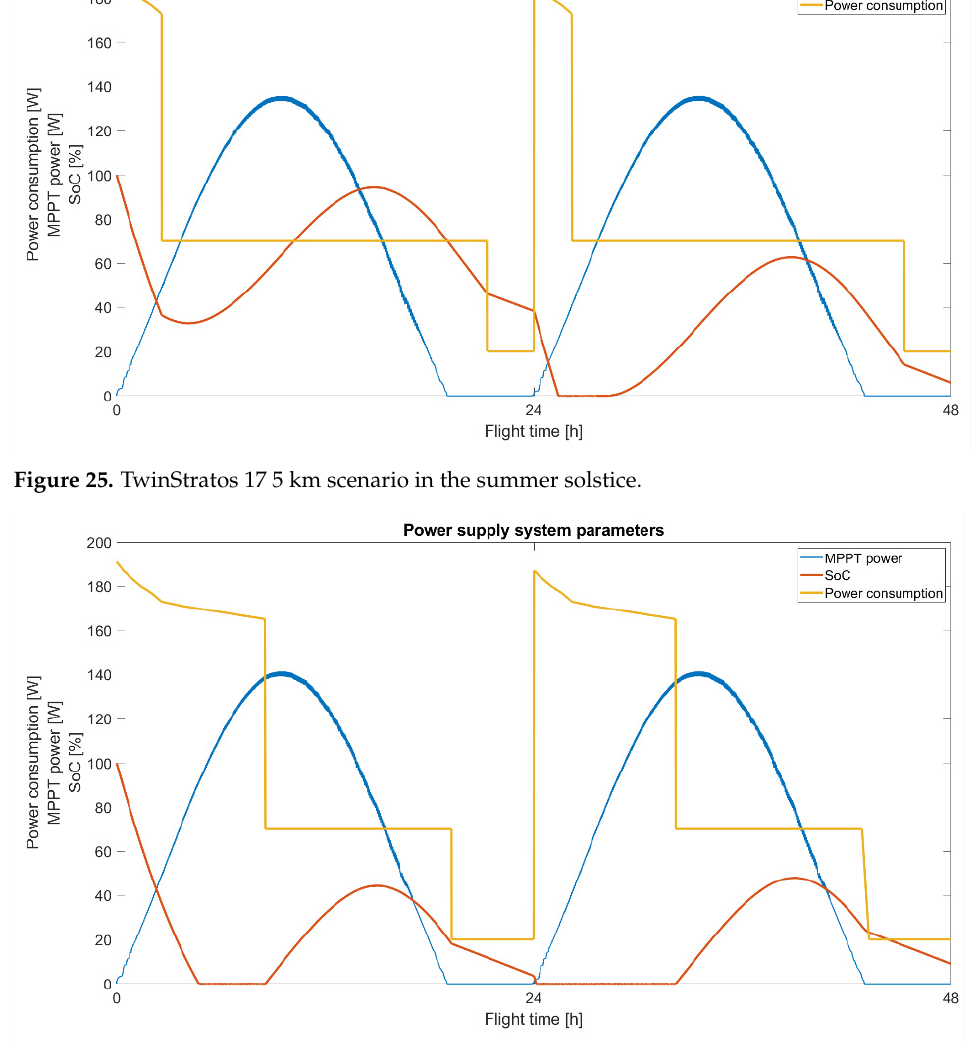
Figure 26. TwinStratos 17 8 km scenario in the summer solstice.